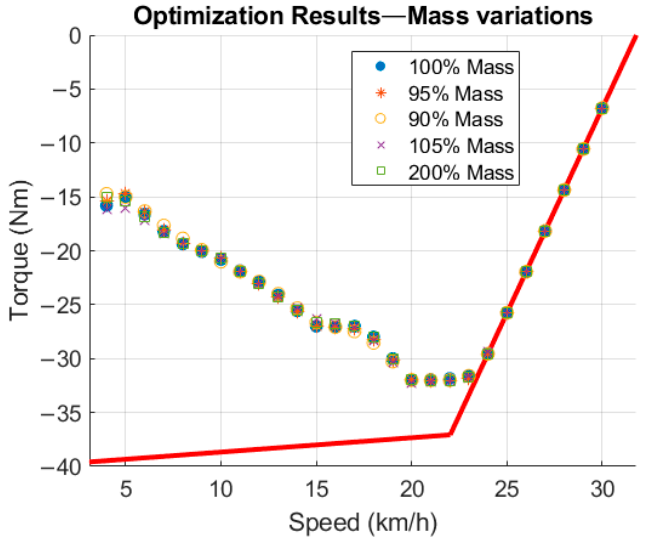
Figure 7. Optimization results for the mass parameter change.